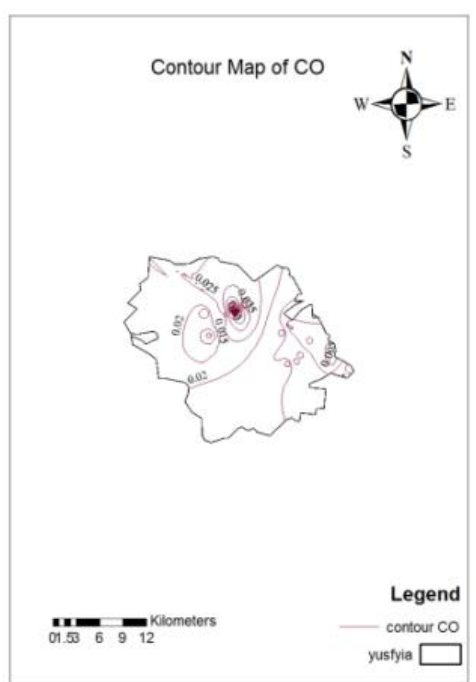
Fig.14: The interpolation and contour line of Co map in ppm.